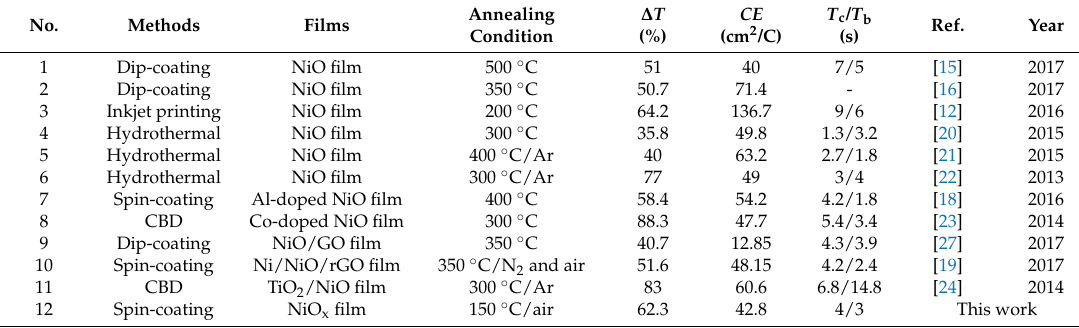
Table 1. NiO-based films reported earlier by chemical solution methods in KOH